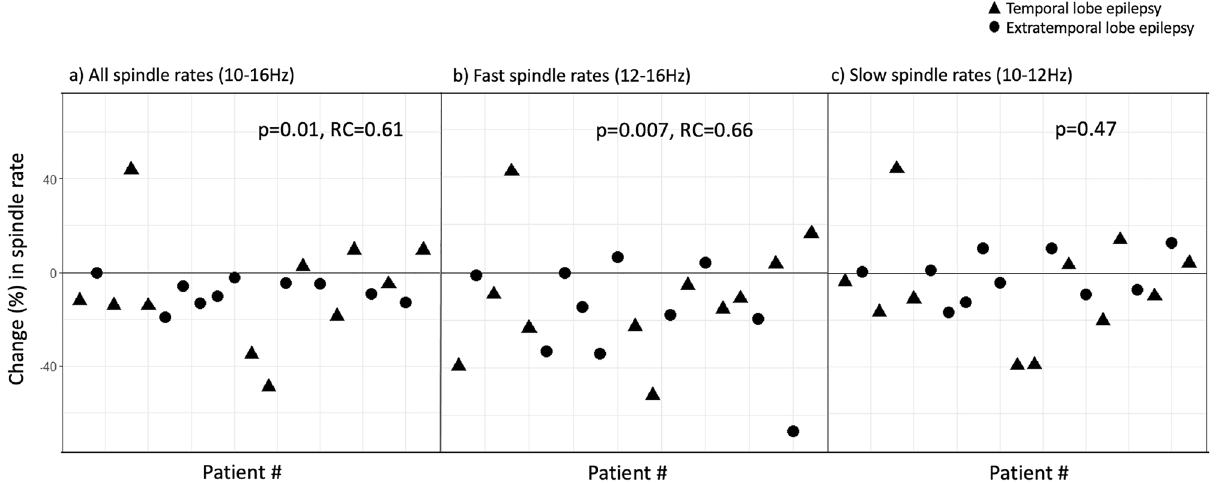
Figure 3. Decrease (%) in ( a ) all spindle (10–16 Hz), ( b ) fast spindle (12–16 Hz) and ( c ) slow spindle (10– 12 Hz) rates for the region with the epileptic focus compared to the contralateral side in early N2 sleep. Each point (circle or triangle) represents a